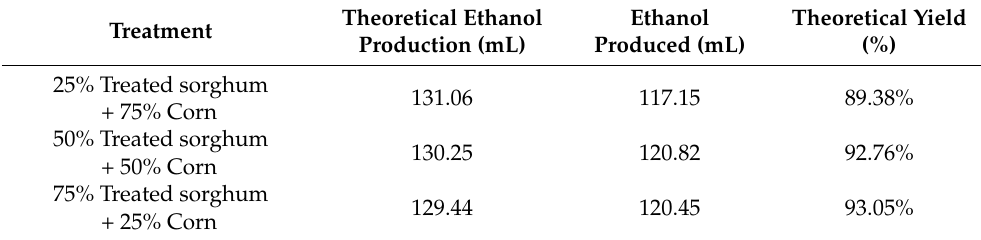
Table 8. Average theoretical yield of sorghum fermentations with cellulase added.